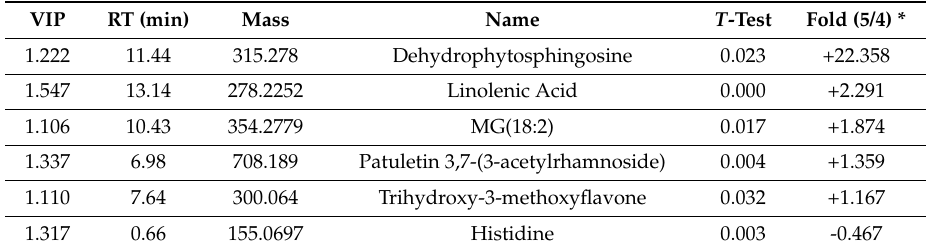
Table 7. The main identification obtained between 4 days and 5 days in ESI+ ( p <